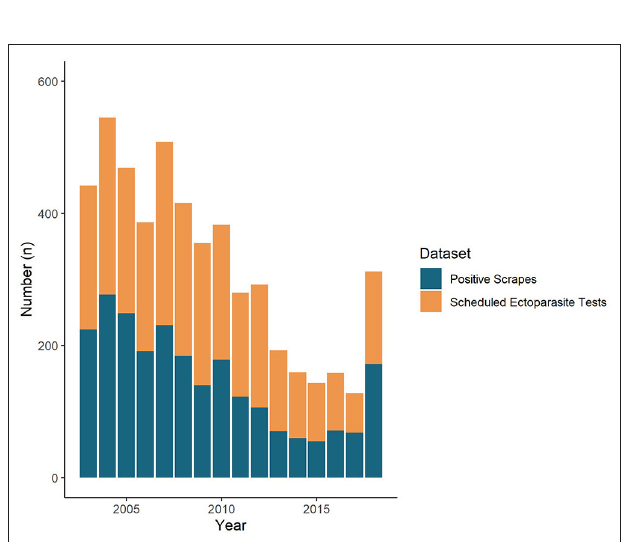
FIGURE 2 | Annual trend of the number of scheduled ectoparasite tests ( n = 5,171) and VIDA positive scrapes for GB from 2003 to 2018 ( n =